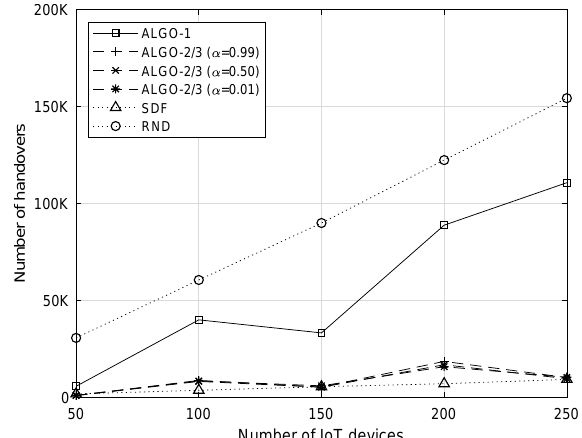
Figure 8. Total number of handovers with respect to the number of IoT devices when v =